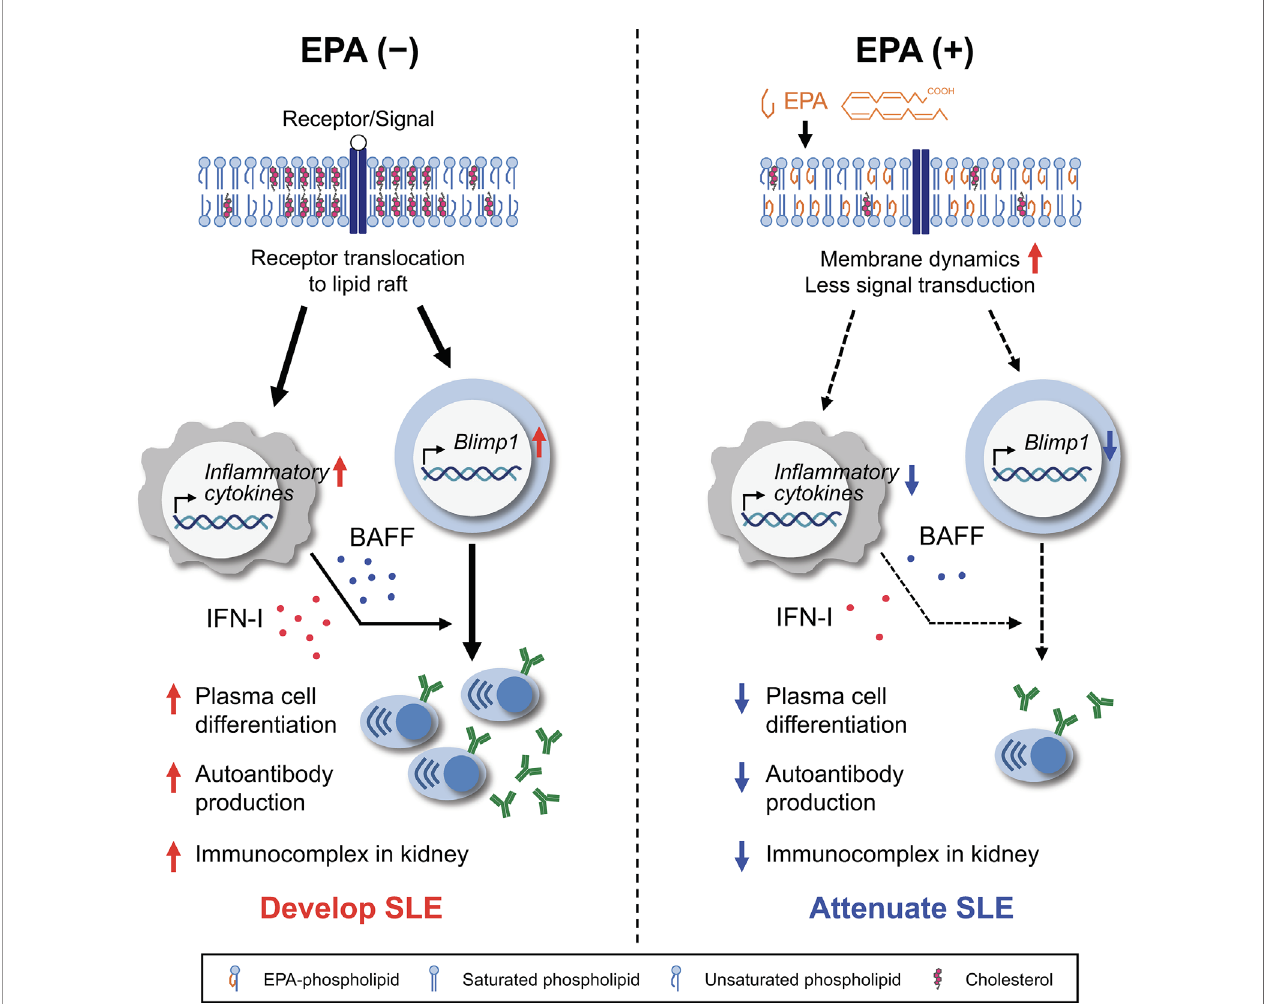
FIGURE 8 | Graphical abstract. Systemic lupus erythematosus (SLE) is a chronic systemic autoimmune disease that is characterized by autoantibody-producing plasma cell differentiation, autoantibody production and immunocomplex deposition in kidney. Production of IFN-I and/or BAFF by antigen-presenting cells (APCs) have been linked to autoantibody production and the pathogenesis of SLE (left). Dietary EPA supplementation ameliorated representative SLE manifestations. EPA suppresses the production of IFN-I and BAFF by APCs. In addition, EPA remodels the lipid composition and increases membrane fl uidity in B cells, thereby preventing the signal for plasma cell differentiation (right). This study highlights a mechanism by which cellular fatty acids regulates the B cell function in the context of systemic